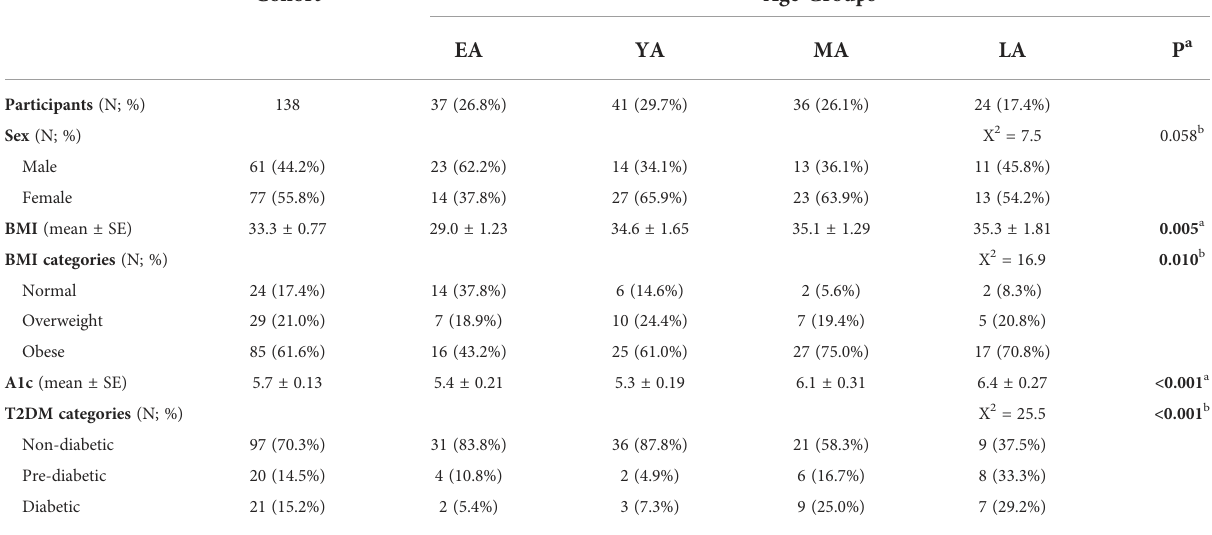
TABLE 1 Sociodemographic and biometric summary of the NHPI-enriched cohort strati fi ed by age into four groups: Early Adulthood (EA; aged 16-20 years), Young Adulthood (YA; aged 21-35 years), Mid-Adulthood (MA; aged 36-55 years), and Late Adulthood (LA; aged 56-80